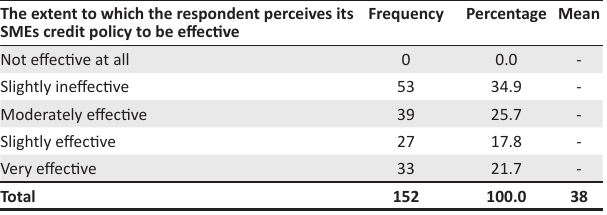
TABLE 2: Small and medium-sized enterprises’ perception of the effectiveness of current credit policy. The extent to which the respondent perceives its SMEs credit policy to be